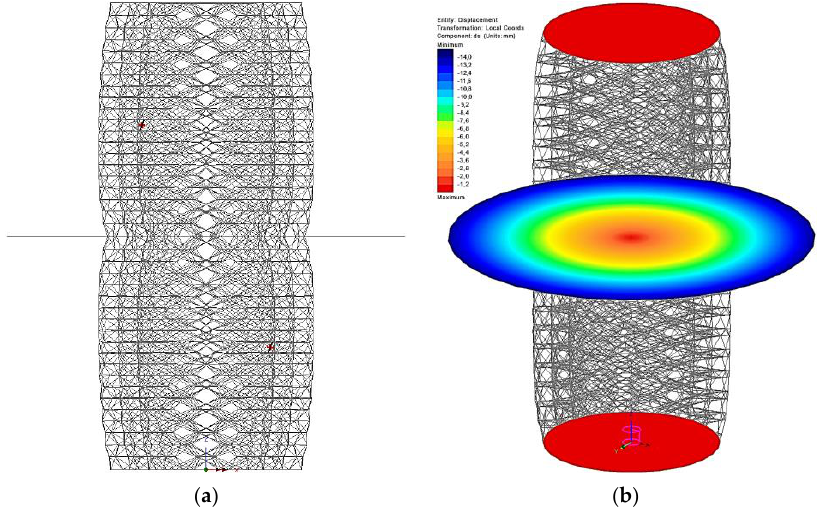
Figure 9. Joint just before fracture: ( a ) first two points of failure in the deformed mesh and ( b ) contours of rotational displacement on the flywheel.